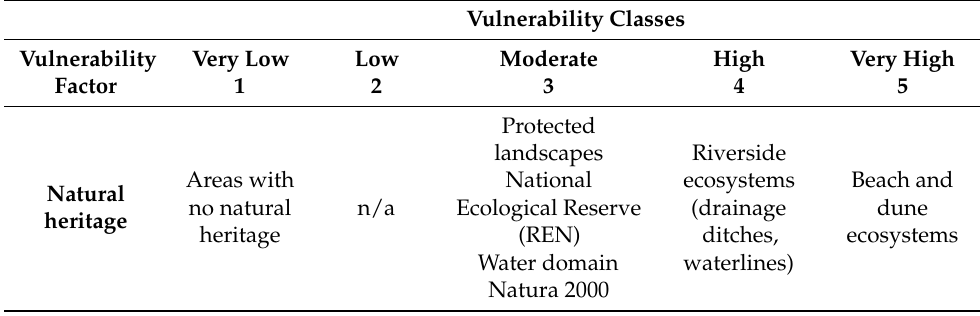
Table 12. Vulnerability classification concerning the natural heritage vulnerability subfactor.